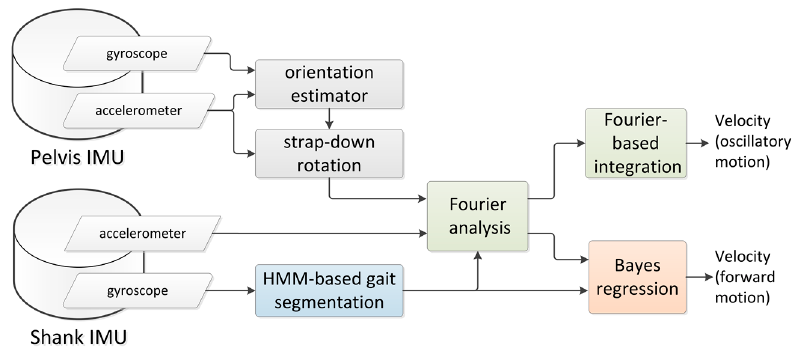
Figure 2. Computational flow of the proposed method.